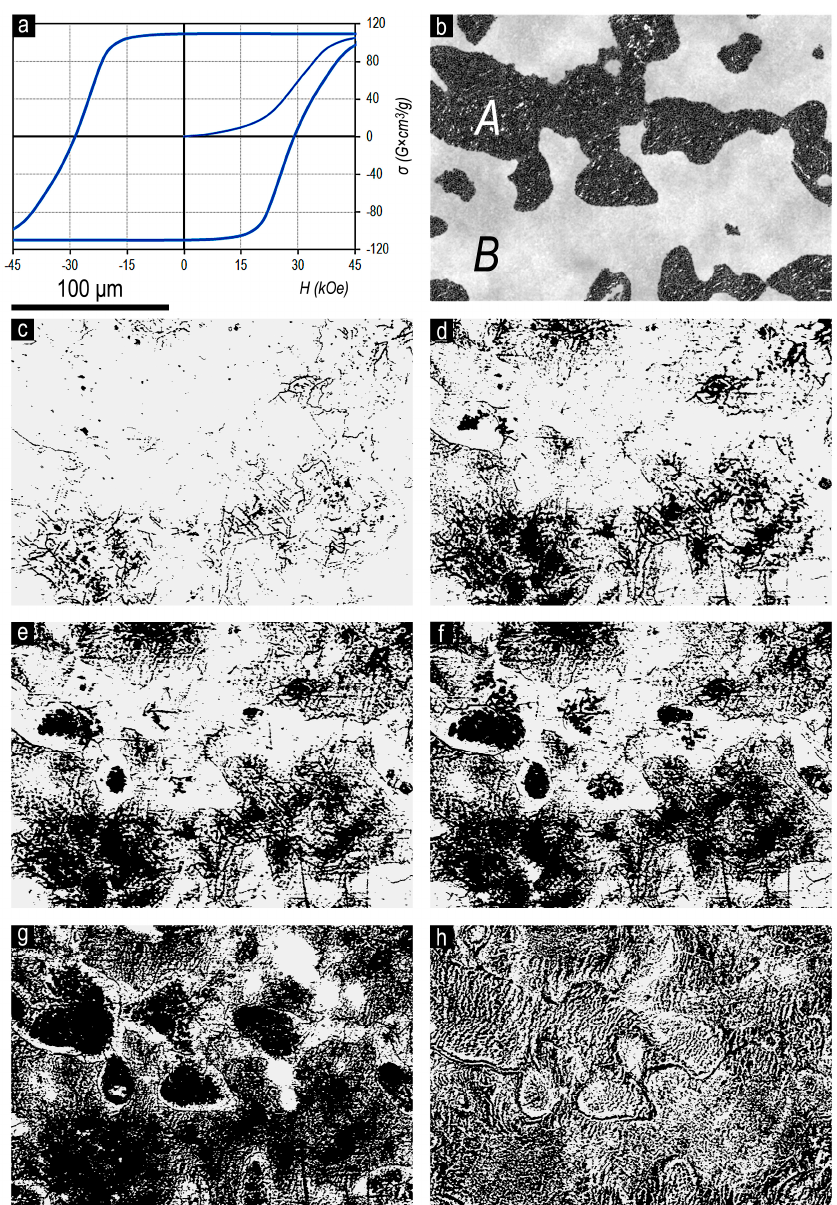
Figure 3. ( a ) Magnetization curve (from the OFVP-demagnetized state) and major magnetic hysteresis loop (without taking into account the demagnetizing factor N = 1 / 3), ( b ) microstructure on the basal plane of the pseudo-single-crystal Sm 0.85 Zr 0.15 (Co 0.702 Cu 0.088 Fe 0.210 ) 6.6 sample, ( c – h ) surface domain structure corresponding to area ( b ) of sample upon progressive magnetization reversal from the magnetic saturation state by the opposite applied field ( c ) 10, ( d ) 15, ( e ) 17.5, ( f ) 20, and ( g ) 30 kOe; Kerr e ff ect, easy magnetization axis is perpendicular to the image plane. ( h ) The domain structure of sample in the OFVP-demagnetized